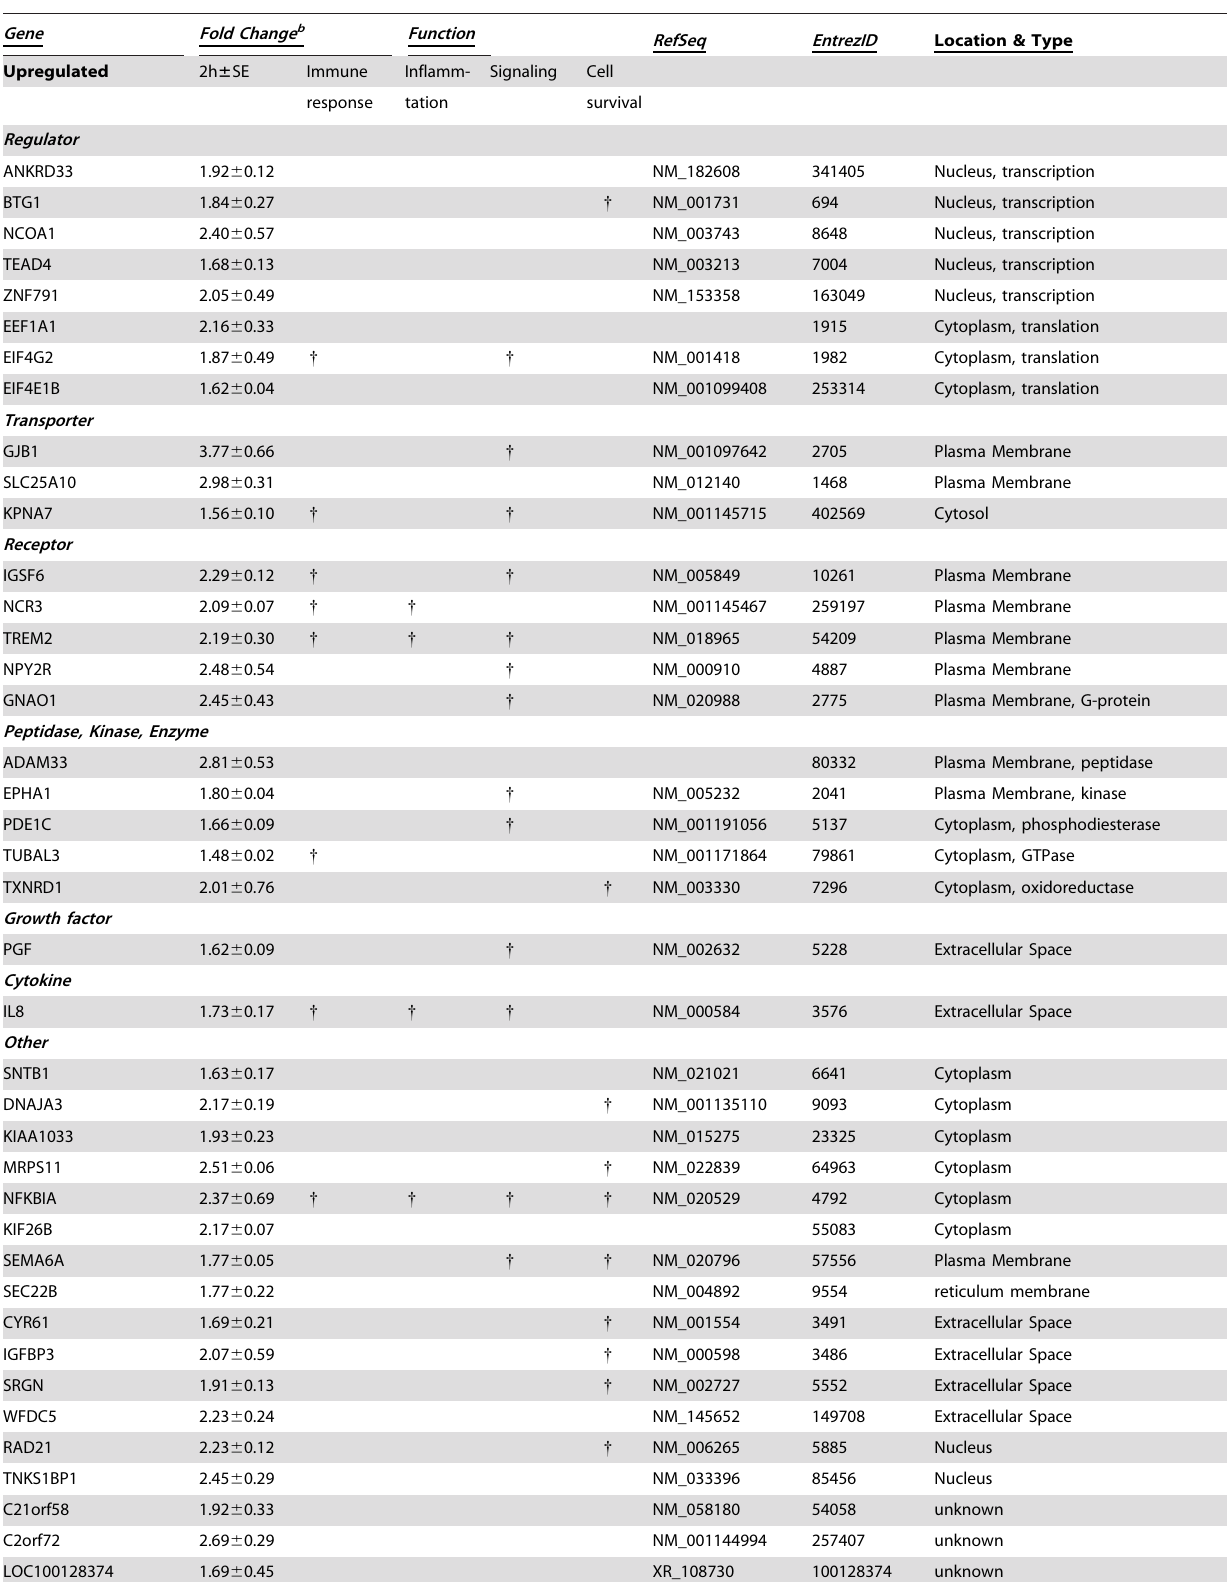
Table 4. Significantly Upregulated Genes in iDCs After E7 Antigen-Peptide Pulsing a .